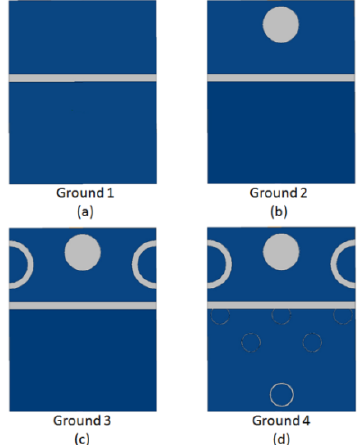
Figure 3. Evolution of the ground structure: ( a ) Partial ground, ( b ) Modified ground plane by DGS as circulars slot, ( c ) added DGS as rings slot at the both sides , ( d ) added DGS as small rings slot